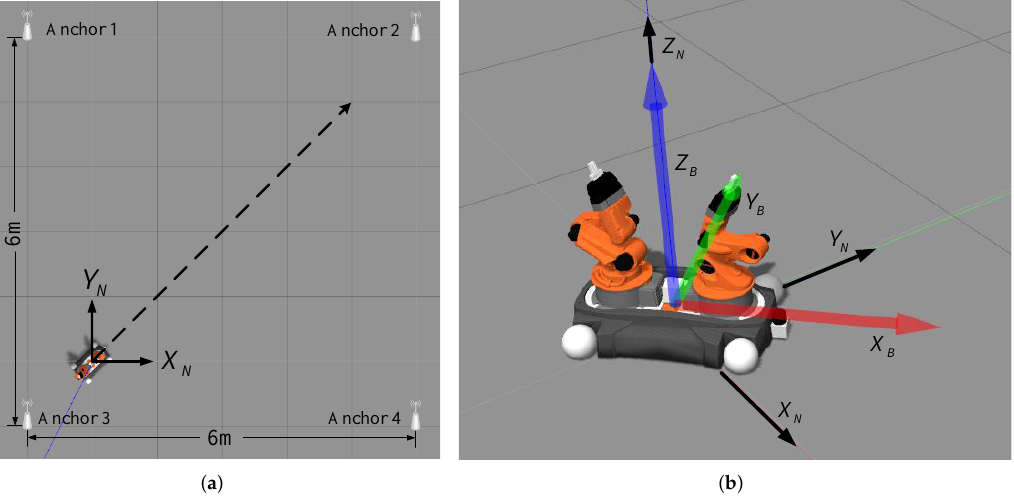
Figure 6. The simulation experiment in Gazebo. ( a ) The initial pose, desired trajectory of mobile robot and distribution of anchors. ( b ) The navigation and body coordinates in